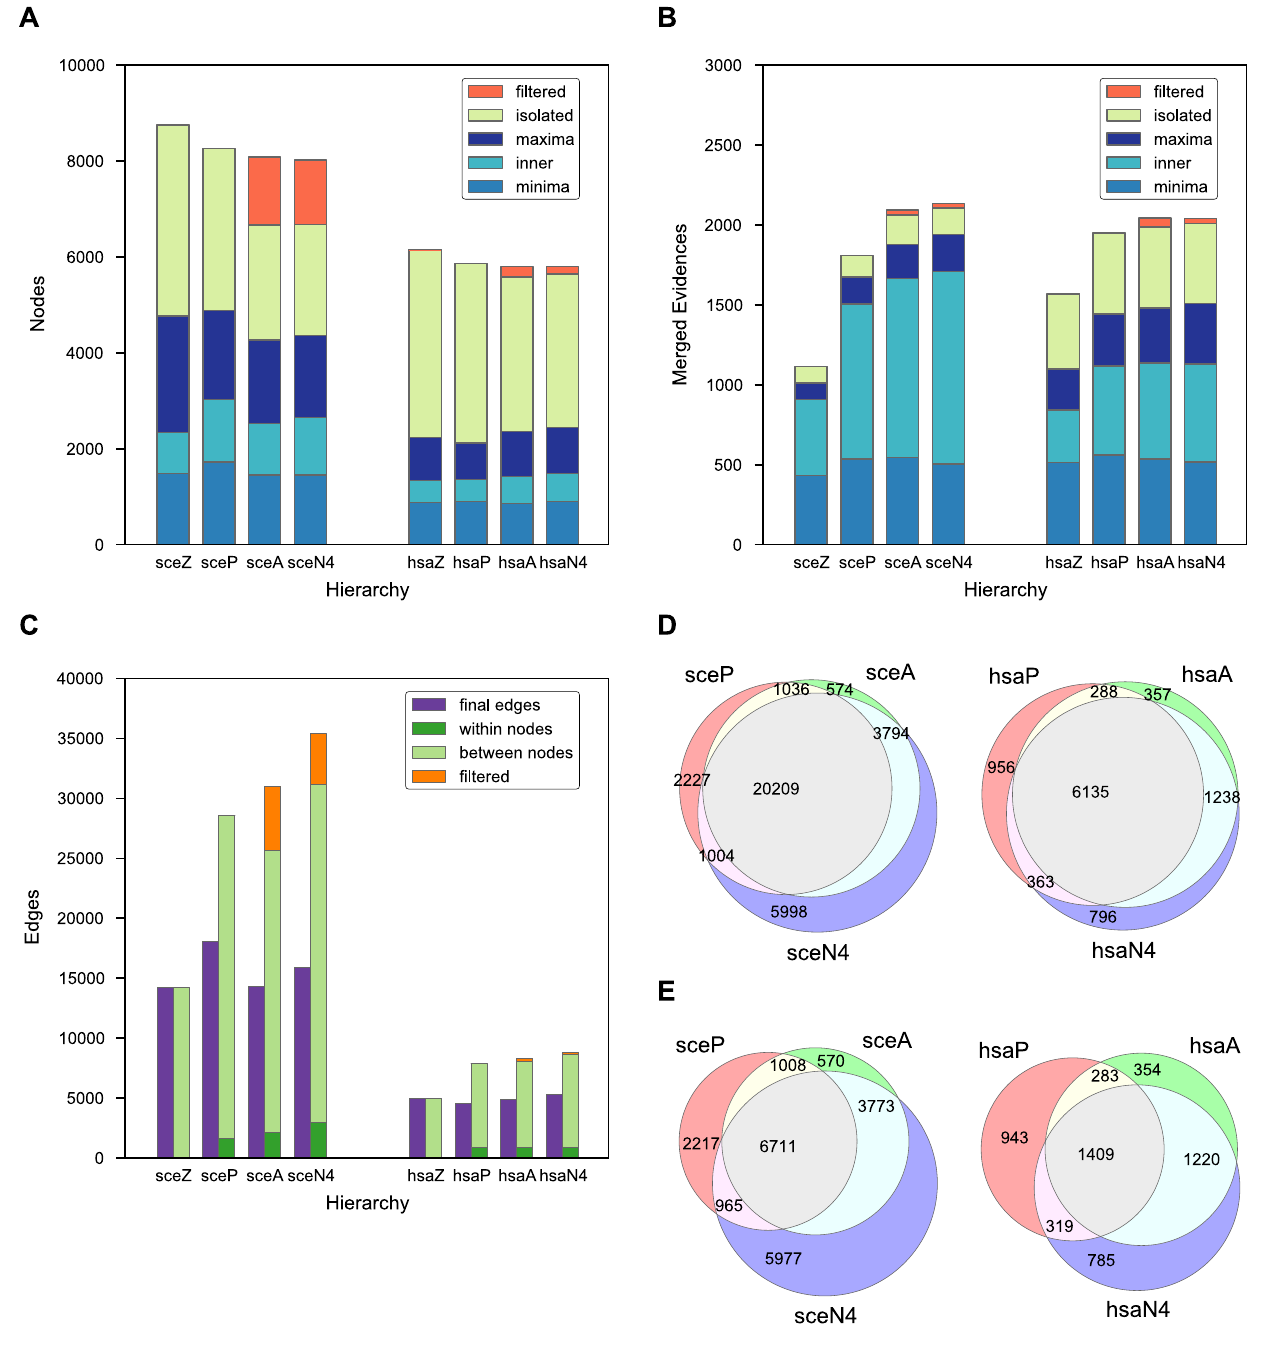
Figure 3. Comparison of complex hierarchies constructed using different protein weighting schemes. A Numbers of nodes. Each node is classified as either filtered (removed due to very small participation ratio), isolated (not connected with any other node), maximum (has only incoming edges), minimum (has only outgoing edges), and inner (has both incoming and outgoing edges). B Numbers of merged evidences. Each node contains one or more original evidences for a protein complex. This chart shows the breakdown of evidences that belong to nodes with more than one evidence, classified according to the type of the containing node. C Numbers of edges. For each DAG, shown are the numbers of total (left) and expanded (right) edges. Expanded edges are obtained by expanding each node into its constituent non-redundant complexes and linking them according to the links between the final nodes (see Methods). They are classified as ‘between nodes’, ‘within nodes’ or ‘filtered’ (either the source or the destination node are filtered). D Overlaps between expanded edges for P, A, and N4 schemes. E Overlaps between expanded edges for P, A, and N4 schemes, where the edges present in the baseline Z scheme are removed.